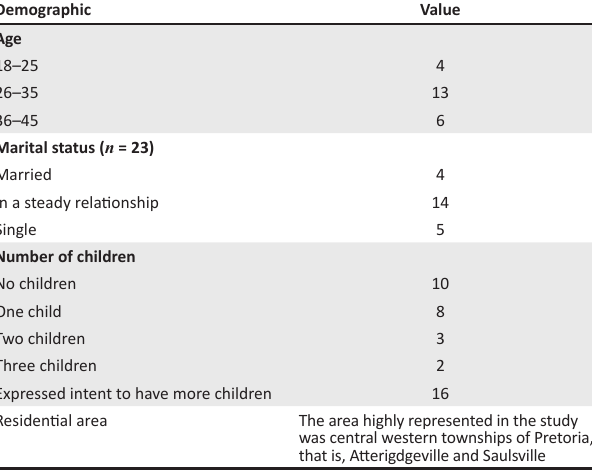
TABLE 1 : Demographic data of 23 female bipolar patients who were interviewed regarding their perceived awareness of teratogenic risks associated with using sodium